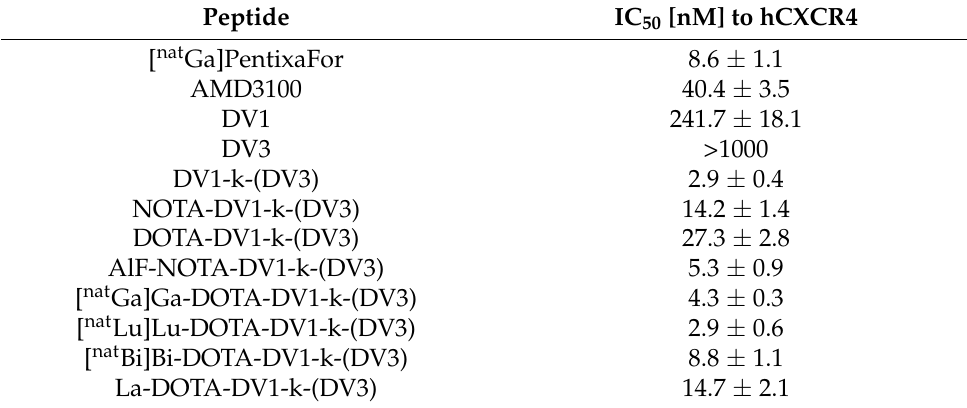
Table 1. Binding affinities (half-maximal inhibitory concentration (IC 50 ) in nM) of [ nat Ga]PentixaFor, AMD3100 and DV1-k-(DV3) derivatives for human CXCR4 (hCXCR4). Affinities for hCXCR4 were determined using Jurkat cells and human CXCL12 AF647 . All data are expressed as mean ± SD ( n =